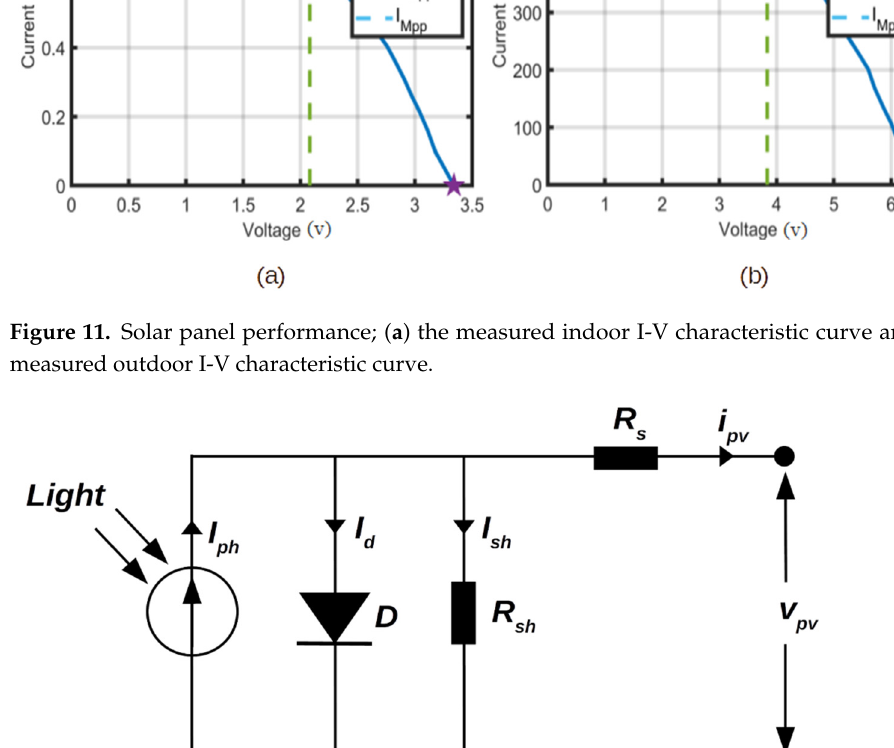
Figure 12. The one-diode model solar cell equivalent circuit.